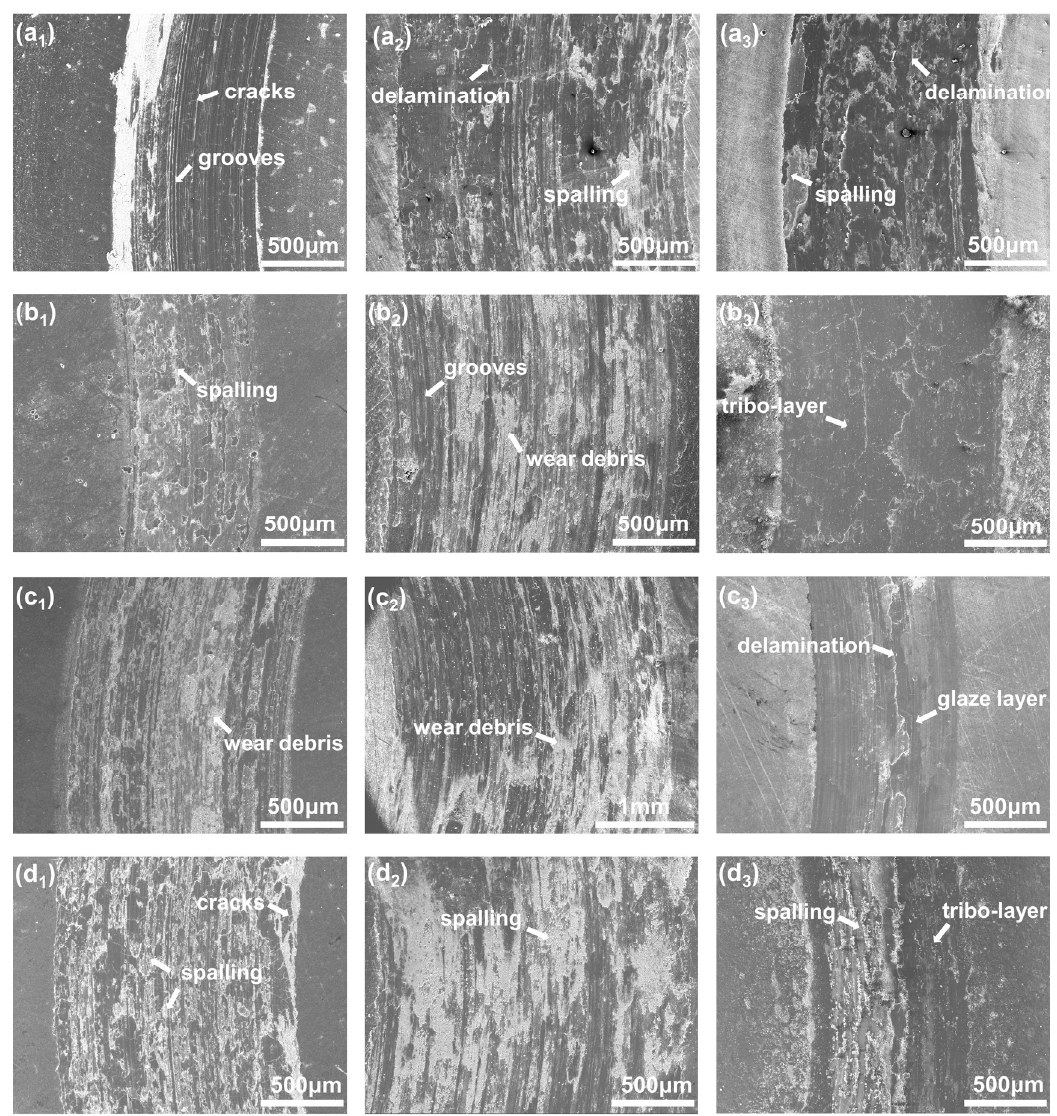
Figure 5. Worn surface SEM morphologies of ( a ) N, ( b ) NM, ( c ) NA, and ( d ) NMA composites tested at ( 1 ) RT, ( 2 ) 400 °C, and ( 3 ) 800 °C.